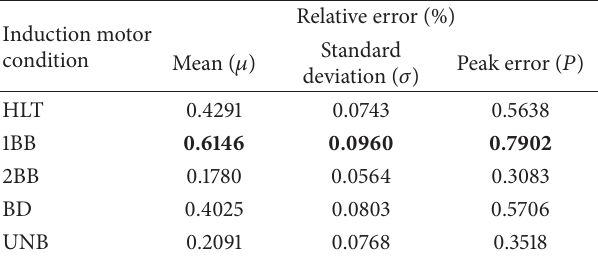
Table 2: FPGA-based implementation performance (the worst values are highlighted in bold).